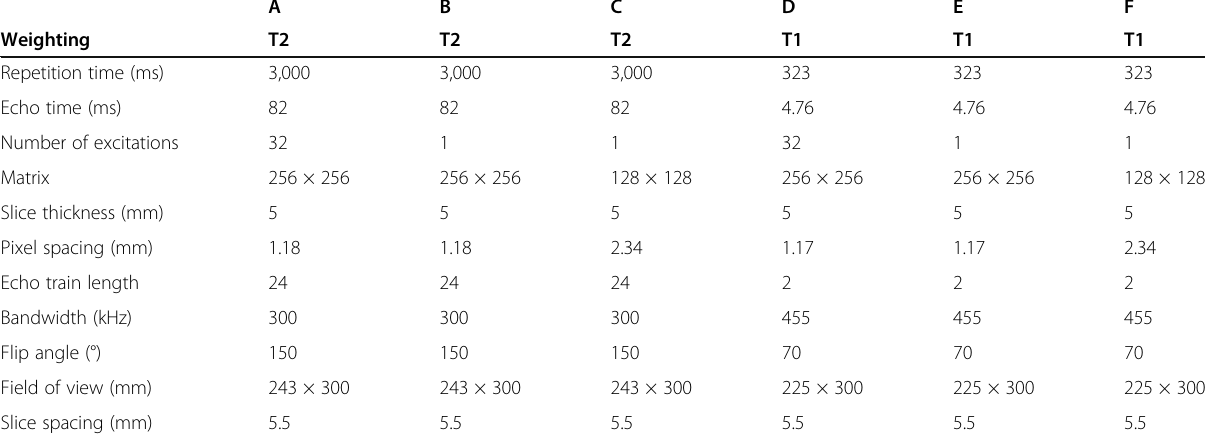
Table 1 Parameters for water and tissue phantom image acquisition in the test-retest study